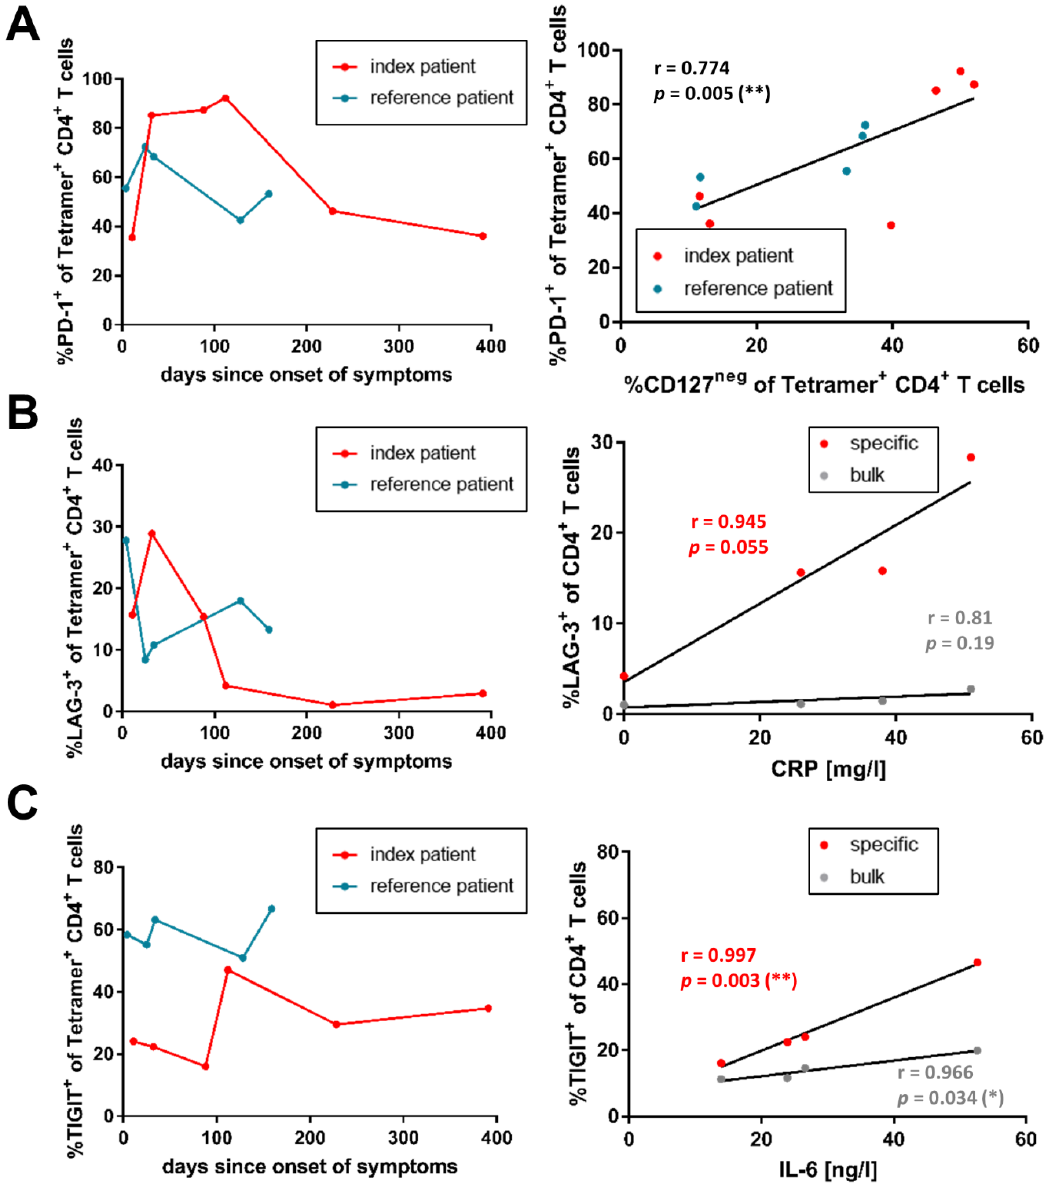
Figure 2. Co-inhibitory receptors on SARS-CoV-2-specific CD4 + T-cells. Expression frequencies of PD-1, LAG-3, and TIGIT on SARS-CoV-2-specific CD4 + T-cells of the index patient (red) and the reference patient (blue), as well as the respective relevant correlations, are depicted. ( A ) PD-1 expression was elevated on virus-specific CD4 + T-cells of the index patient, and correlated with CD127 expression. ( B ) LAG-3 expression on virus-specific CD4 + T-cells was elevated in early infection, and was associated with plasma CRP levels in the index patient (r = 0.945; p = 0.055). ( C ) TIGIT expression was elevated on virus-specific CD4 + T-cells of the reference patient, and significantly correlated with plasma IL-6 levels in the index patient (r = 0.997; p = 0.003). In correlation analyses, each dot represents an individual time point, and values are given as Pearsons’s r. Results were considered statistically significant if p < 0.05. Levels of significance are translated to asterisks as follows: ns p ≥ 0.05; * p < 0.05; ** p < 0.01. As described previously [50], an increase in LAG-3 + bulk CD4 + T-cells to a maximum of 2.77% (index patient, day 32) and 2.64% (reference patient, day 4), compared to healthy individuals (median 1.07%, IQR 0.86–1.62%), could be observed during the acute infection